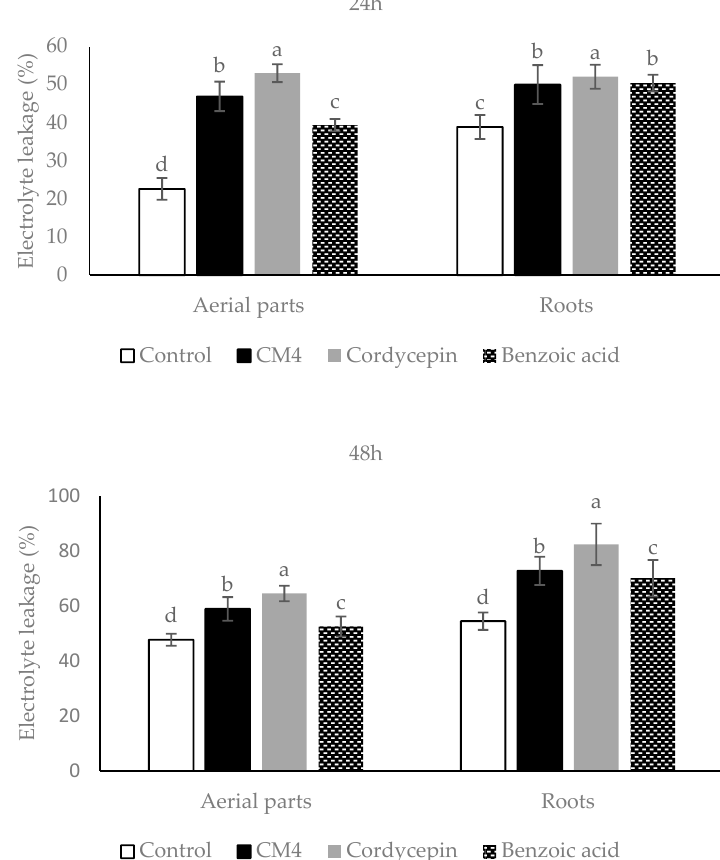
Figure 3. Electrolyte leakage (%) of radish treated by CM4 fraction, synthetic cordycepin and BA at 0.04 mg/mL. Columns with similar superscript letters ( a,b,c,d ) in bars were not significantly different according to Fisher’s test ( p <0.05).